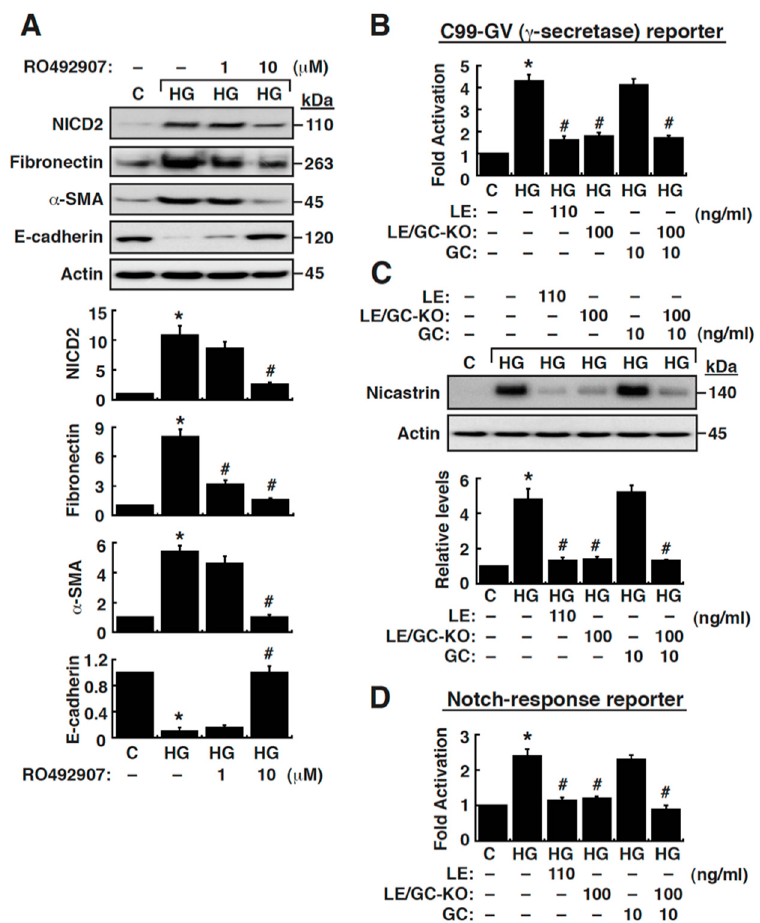
Figure 5. An elevated γ -secretase activity is essential for HG-induced cell fibrosis, which can be blocked by LE or LE / GC-KO. ( A ) E ff ect of the γ -secretase inhibitor RO492907 on the expression of NICD2 and EMT markers in HG-cultured NRK-52E cells. At 48 h after treatment, cells were harvested for Western blotting. ( B ) Measurement of γ -secretase activity by reporter assay in NRK-52E cells under di ff erent treated conditions. Details of the measurement of the γ -secretase activity in treated cells using the Gal4-driven luciferase reporter plasmid and the C99-GV expression plasmid were described in Materials and Methods. At 48 h after transfection and treatment, cells were lysed, and luciferase assays were performed. ( C ) Changes in the expression of nicastrin in HG-cultured NRK-52E cells treated with LE, LE / GC-KO or GC at the indicated concentrations. At 16 h after treatment, cells were harvested for Western blotting. ( D ) Evaluation of activation of a Notch-response reporter construct (Hes5) in NRK-52E cells under di ff erent treated conditions. At 48 h after transfection and treatment, cells were lysed, and luciferase assays were performed. * p < 0.05 versus the normal control, # p < 0.05 versus untreated HG-cultured cells ( n = 3).